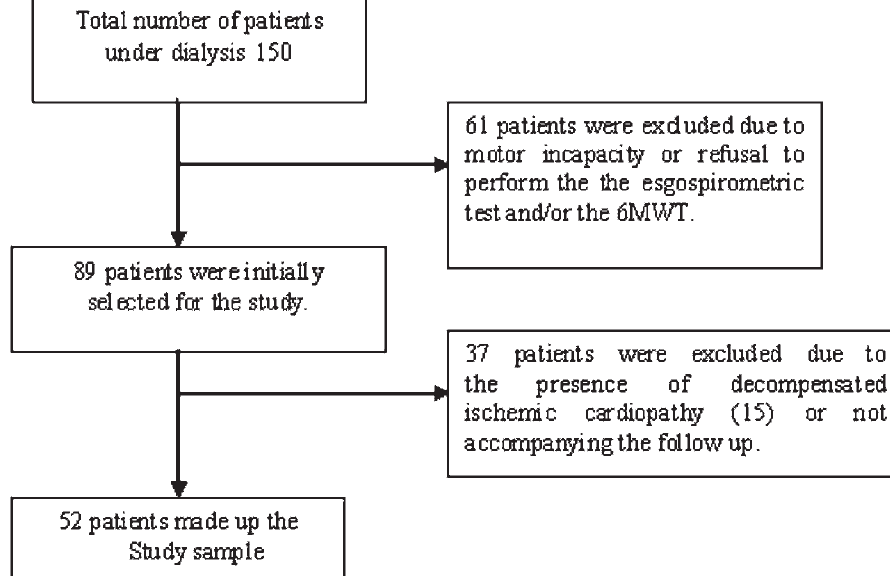
Figure 1 - Flowchart of the patients allocated in the study.